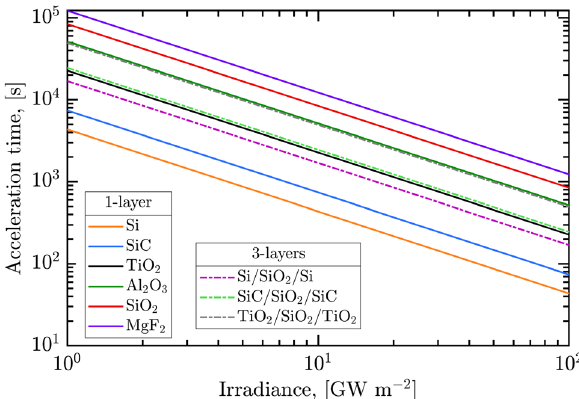
Fig. 3 Areal density, FOM and re fl ectance of lightsails. The areal density (red bar) and (average) the re fl ectance (green bar) are shown for some selected structures, as grouped by the number of layer. For each group, the value of the FOM (blue bar) increases from left to right.